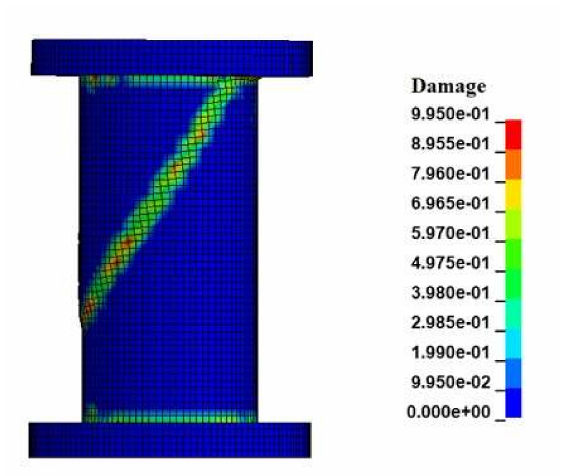
Figure 12. Uniaxial compression shear damage zone of Indian limestone.